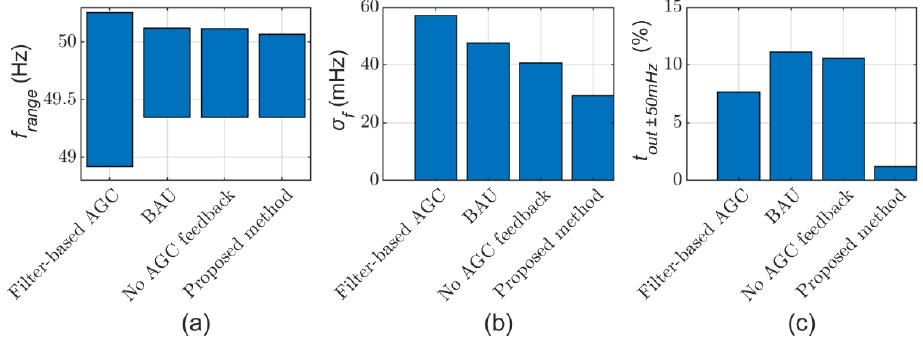
Figure 9. Frequency quality metrics, for cases (i)–(iv). ( a ) Frequency range, ( b ) frequency standard deviation, ( c ) time outside 49.95–50.05 Hz.